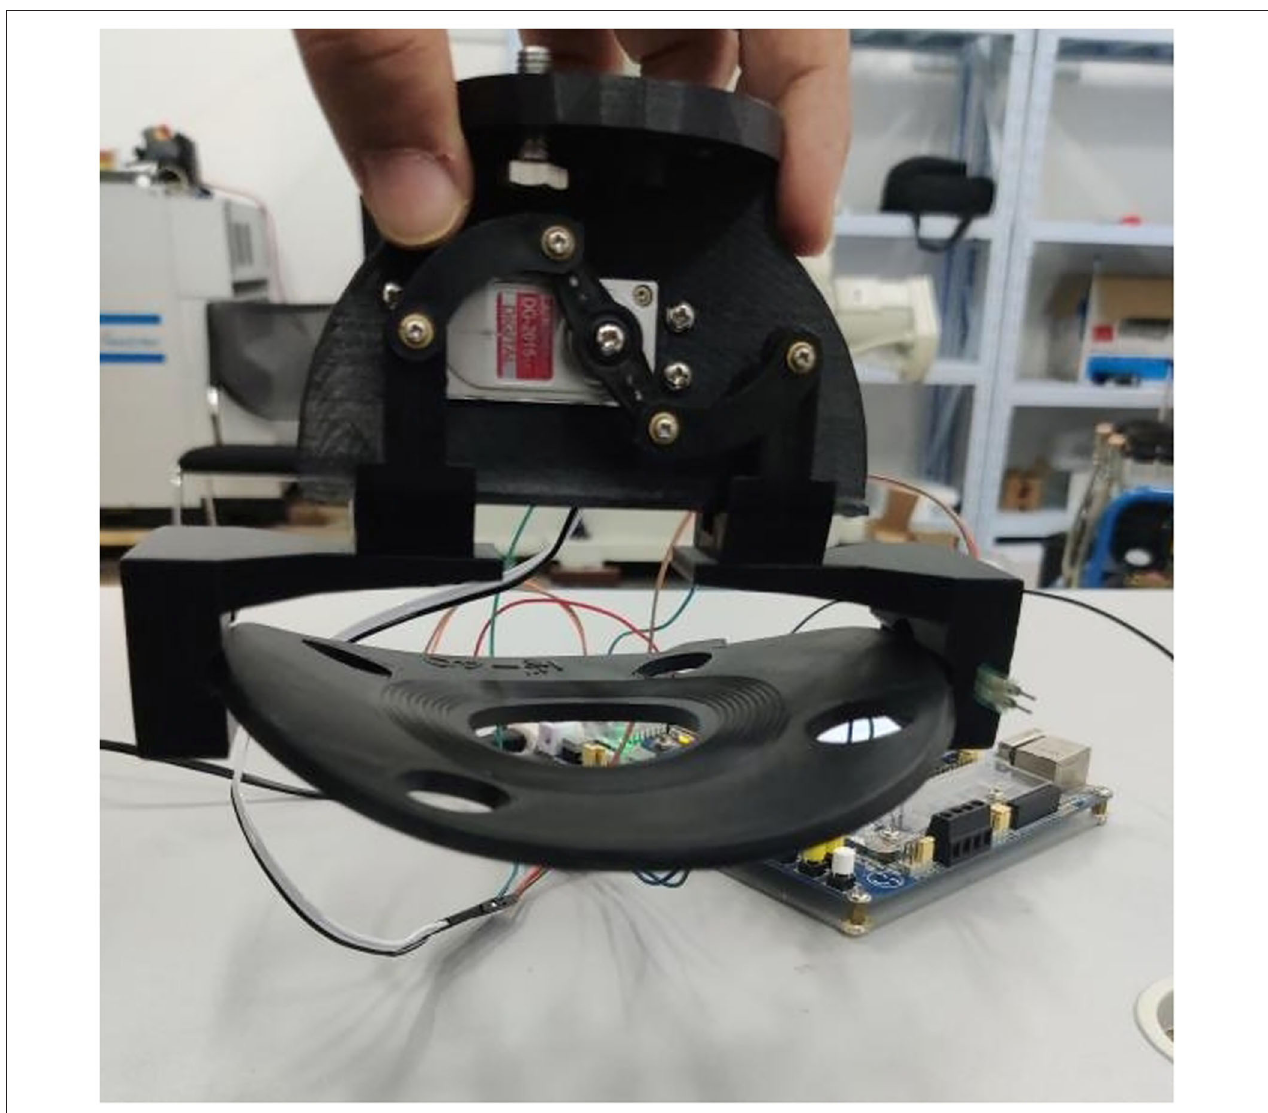
FIGURE 8 | The gasket produces the deformation effect during the grasping